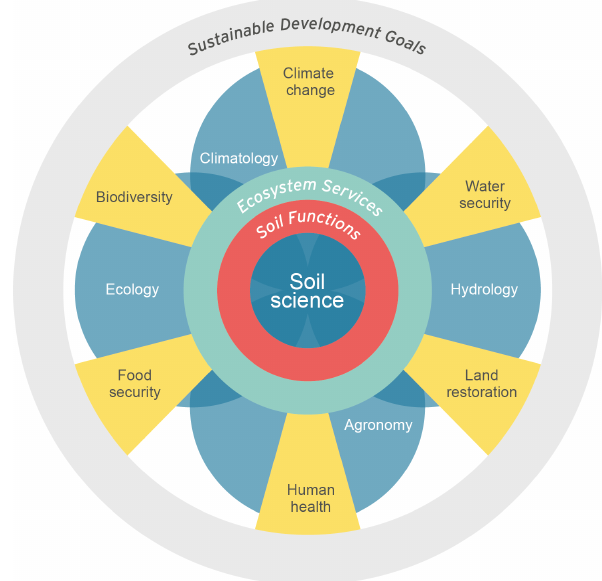
Figure 1. Six major global issues, each of which relates to one or more of the SDGs: (i) food security; (ii) human health; (iii) land management, including land restoration; (iv) water security; (v) cli- mate change; and (vi) biodiversity preservation. Each of these is- sues will be discussed in short essays, loosely based on discussions held at the EGU Soil Conference in Vienna in April 2015 and at the Wageningen Conference on “Soil Science in a Changing World” in August